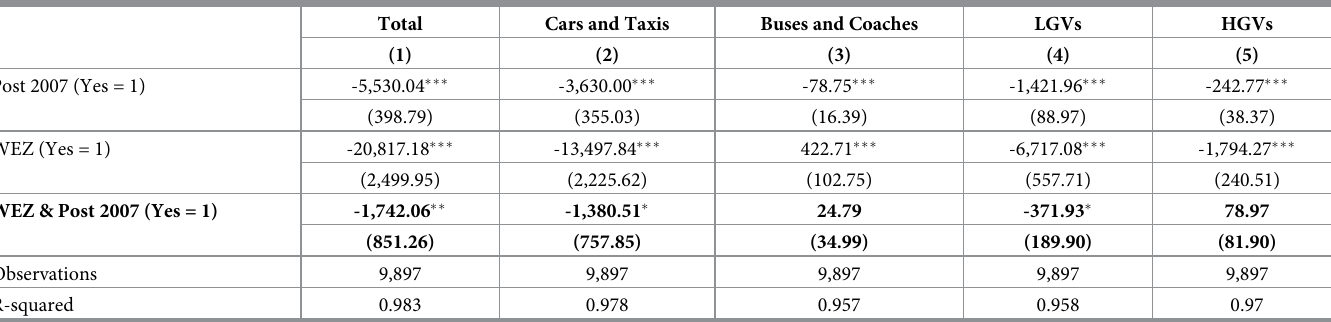
Table 4. Buffer test DiD estimates—Introduction of the